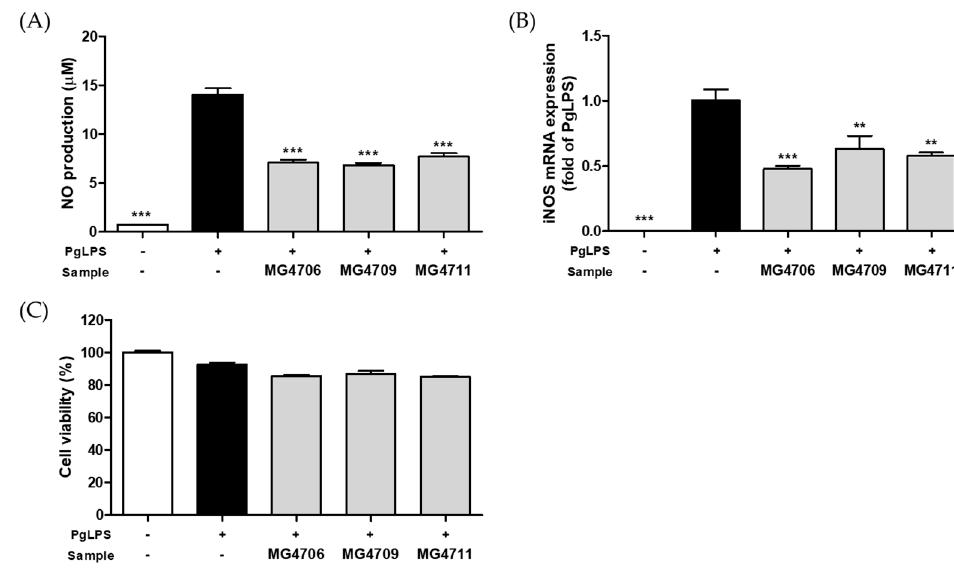
Figure 1. Effect of cell-free supernatant (CFS) from lactic acid bacteria (LAB) on ( A ) nitric oxide (NO) production, ( B ) inducible nitric oxide synthase ( iNOS ) mRNA expression, and ( C ) cytotoxicity in P. gingivalis LPS (PgLPS)-activated RAW264.7 cells. Data are represented as mean ± SEM ( n = 3). Significance was analyzed using Dunnett’s test. ** p < 0.01, *** p < 0.001 versus only treated-PgLPS group.